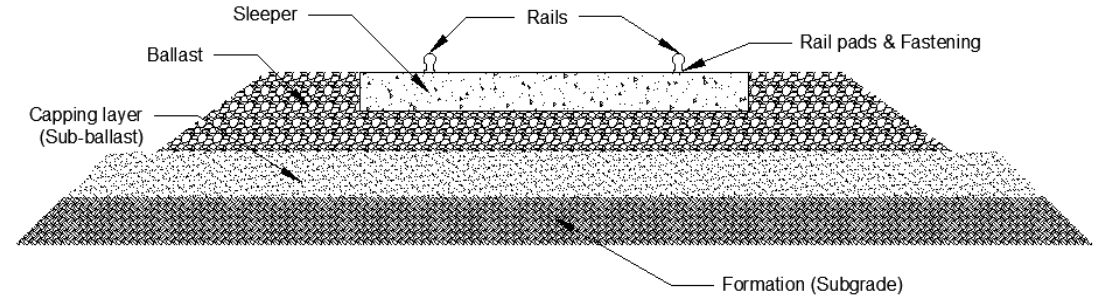
Figure 2. Conventional railway structure.